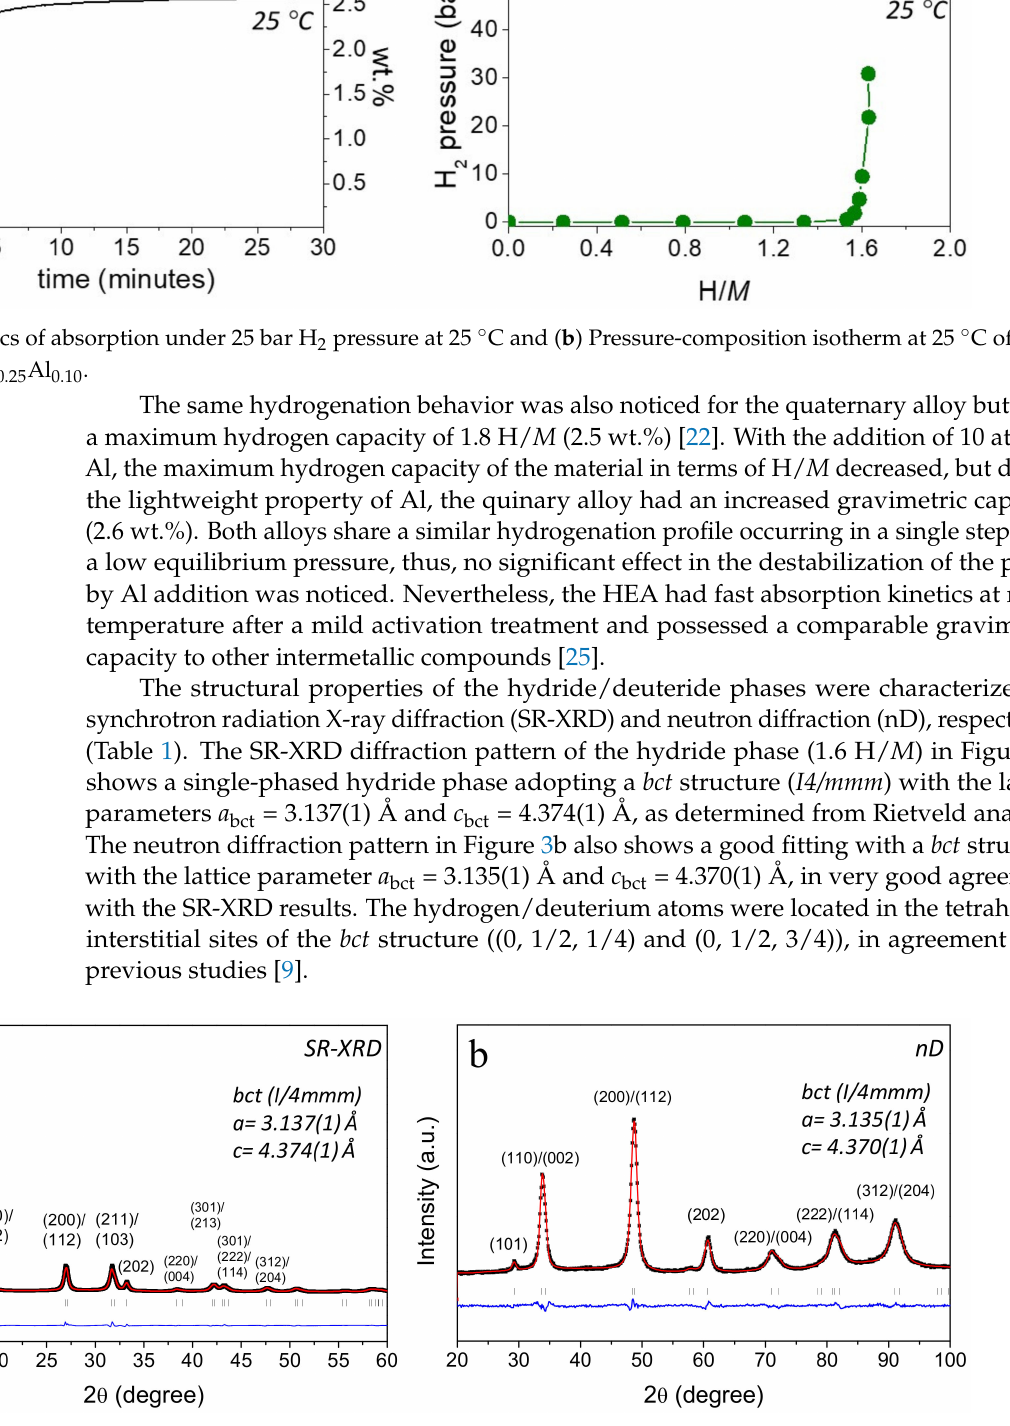
Figure 3. ( a ) Synchrotron radiation (SR)-XRD pattern ( λ = 0.72896 Å) of the hydride Al 0.10 Ti 0.30 V 0.25 Zr 0.10 Nb 0.25 H 1.6 and ( b ) ex situ neutron diffraction pattern ( λ = 1.28 Å) of the deuteride Al 0.10 Ti 0.30 V 0.25 Zr 0.10 Nb 0.25 D 1.6 . The corresponding Rietveld refinements and bct lattice parameters are also